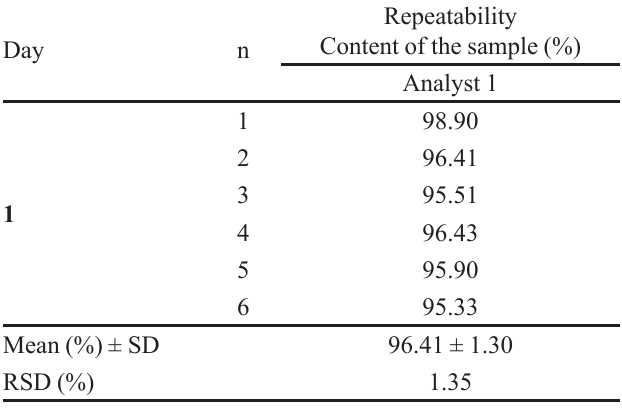
TABLE III - Analytical parameters and variations to evaluate the repeatability of the chromatographic method for